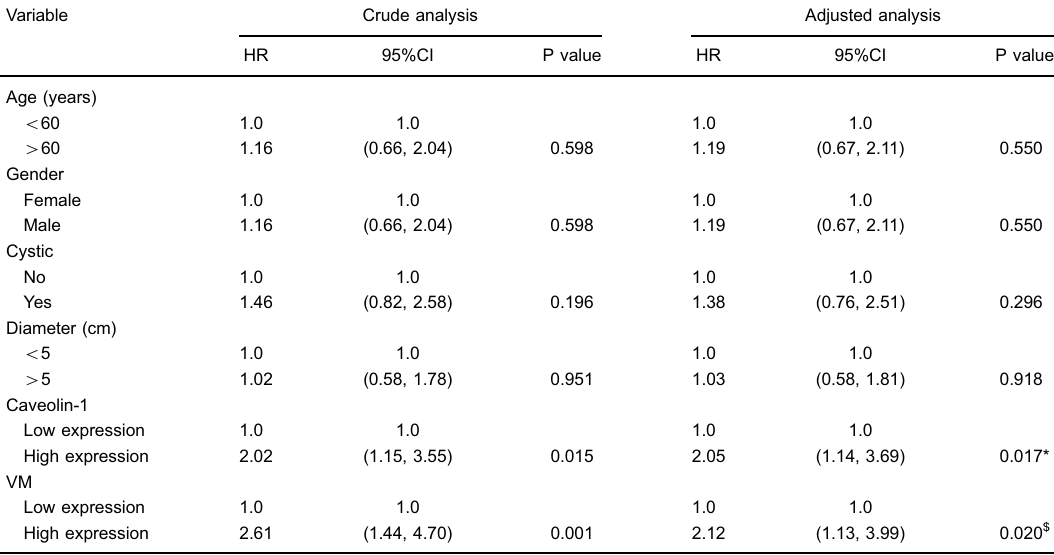
Table 1. Cox proportional hazards regression analysis in 94 glioblastoma